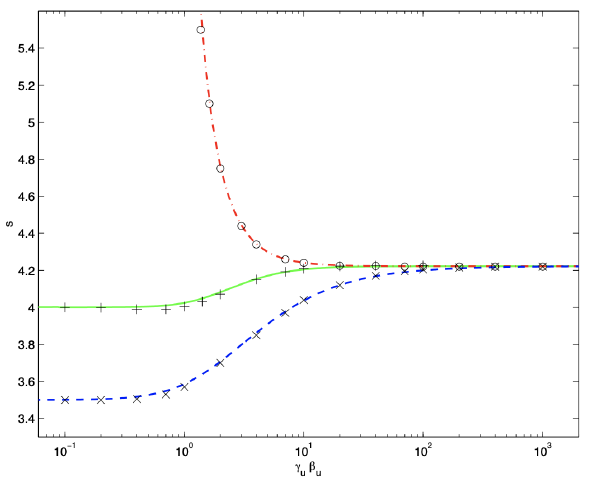
Figure 1. Spectral index ( s p = p + 2) of the electrons accelerated in shocks as a function of the shock velocity. Curves refer to the equation derived by [61] under the hypothesis of isotropic, small-angle scattering and is a generalization of the non-relativistic formula. Symbols show the comparison with numerical studies. Different curves refer to different assumptions on the type of shock (see [61] for details): in all cases, the value of the spectral index approaches the same value s p ∼ 4.2 (corresponding to p ∼ 2.2) in the ultra-relativistic